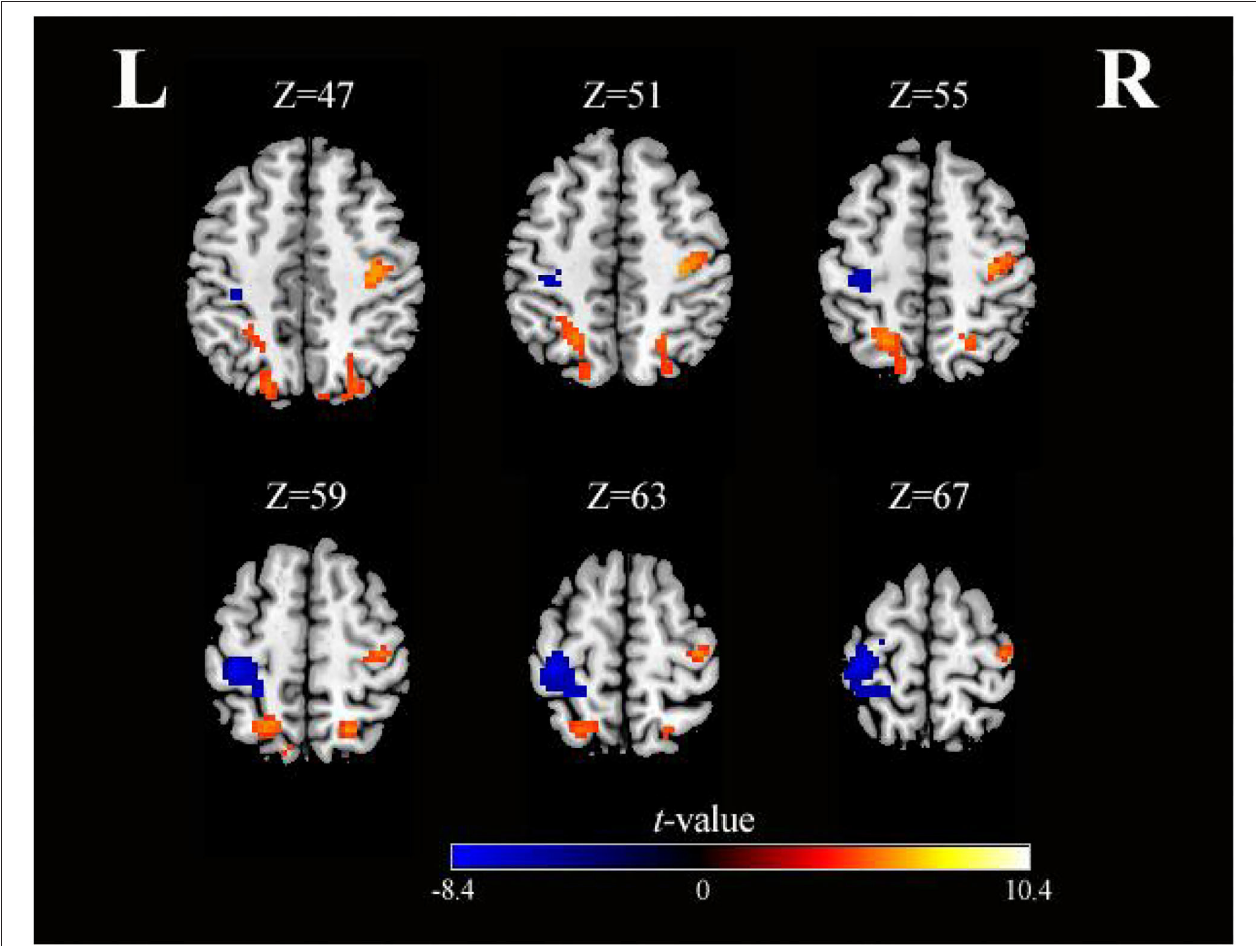
FIGURE 4 | Axial slices with corresponding Z-coordinates (MNI) from the t -value map for differential activation of SO and SS (voxel-level, FDR-corrected p < 0.001, cluster size > 10 voxels). MNI, Montreal Neurological Institute; SO, sensory observation; SS, somatosensory stimulation; FDR, false discovery rate; L, left; R, right .